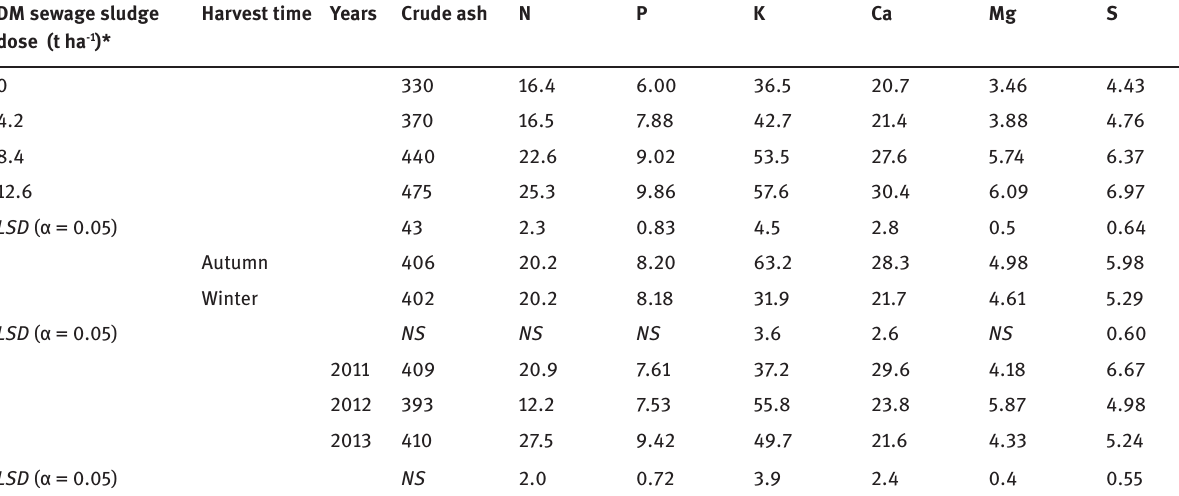
Table 9: Crude ash and macronutrients (kg ha -1 ) in harvested Prairie cordgrass (means by factors and years).